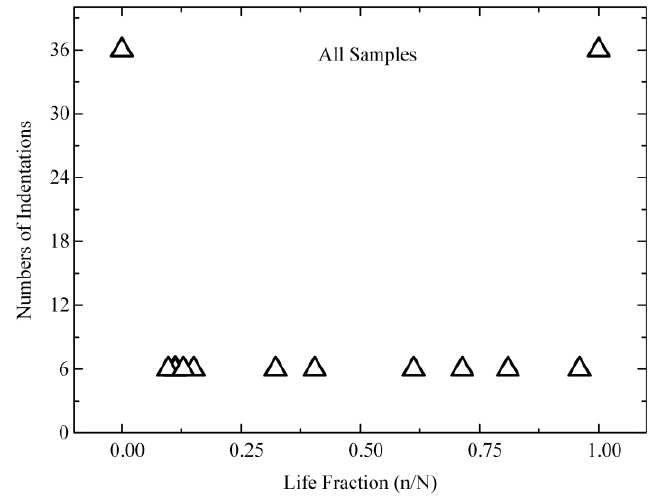
Figure 2. A graphic of the relationship between the nanoindentation test and fatigue life.